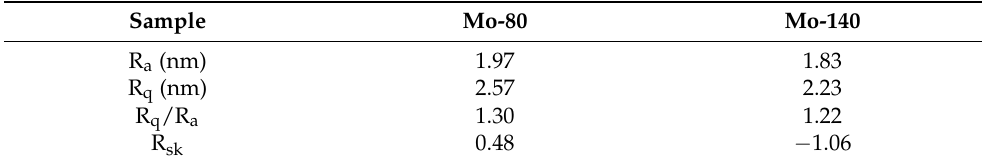
Figure 2. AFM roughness levels R a and R q of Mo-80 and Mo-140 samples, respectively. Table 2. AFM parameters of Mo thin film with deposition power variation.